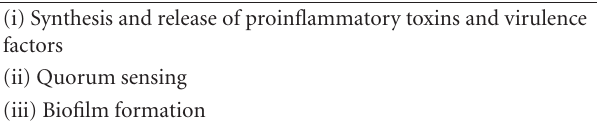
Table 1: Targets of the pathogen-directed anti-inflammatory activities of macrolide